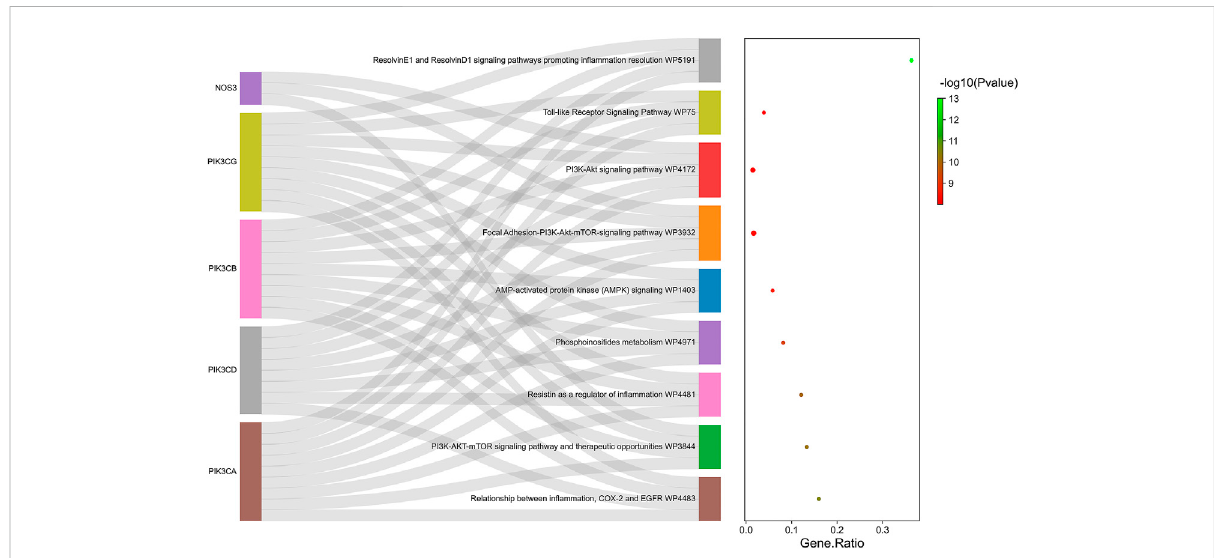
TABLE 1 Top ten KEGG pathways terms of common target genes of disease-compound. Term Overlap p -value Adjusted